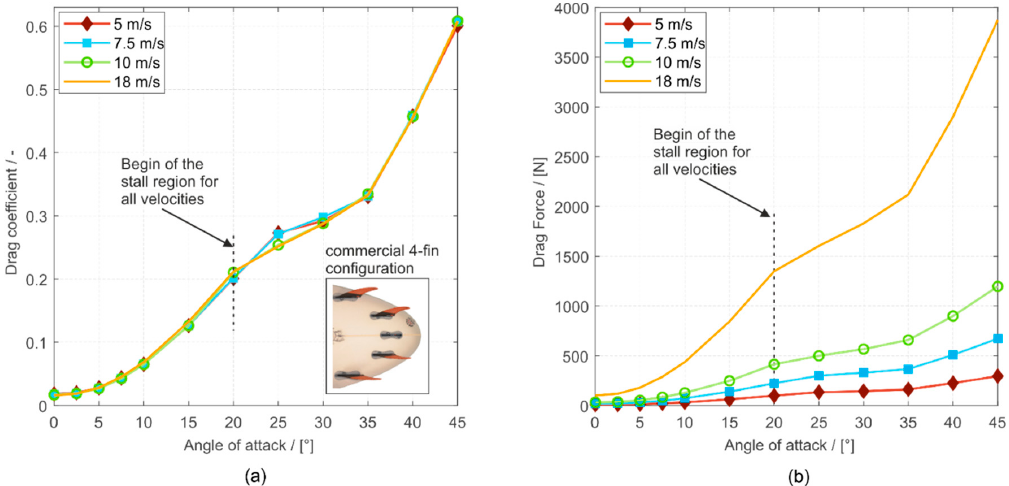
Figure 13. ( a ) Mean drag coefficient of the four velocities for the entire 4-fin configuration versus the AoA and ( b ) the mean drag force of the four velocities for the entire 4-fin configuration versus the